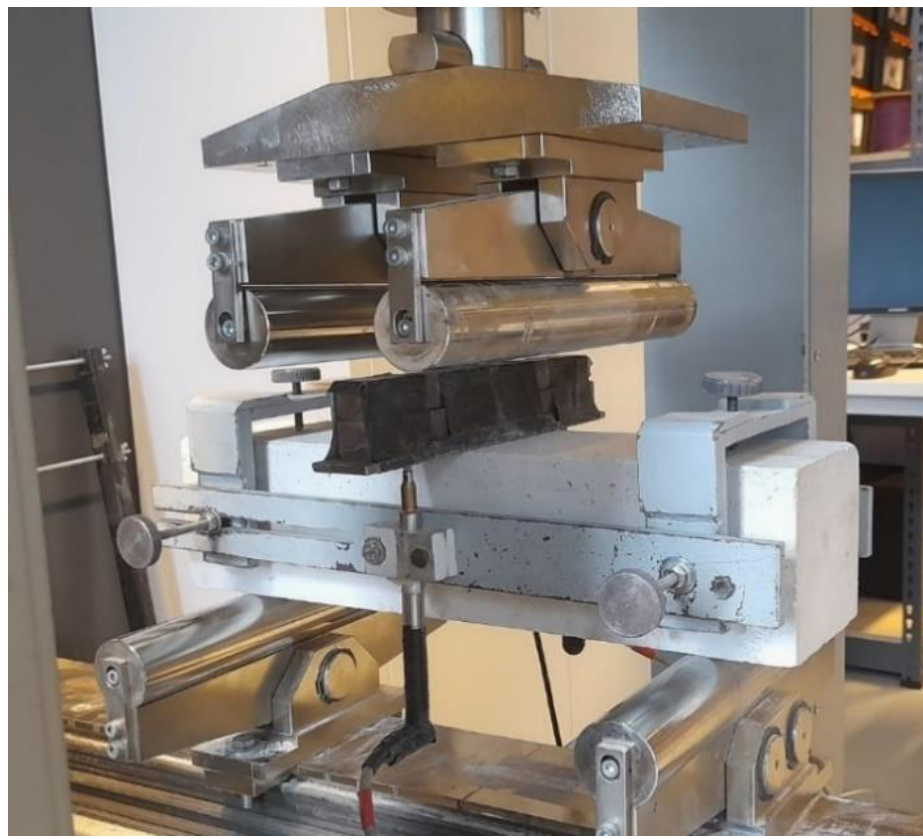
Figure 2. Four Point Bending Test